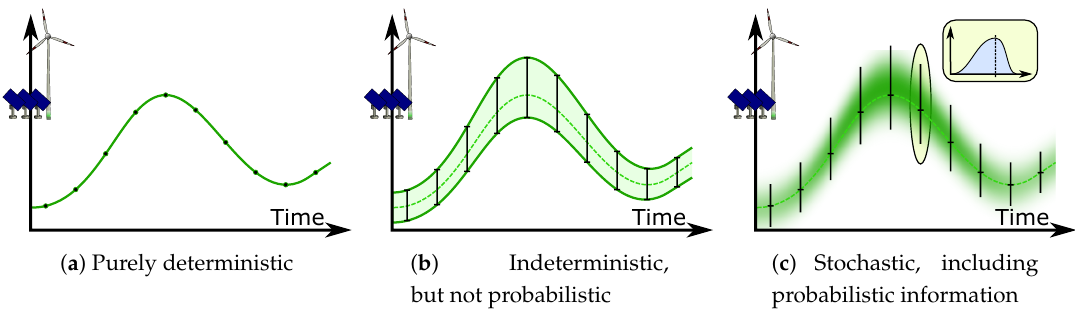
Figure 5. Observed model and input